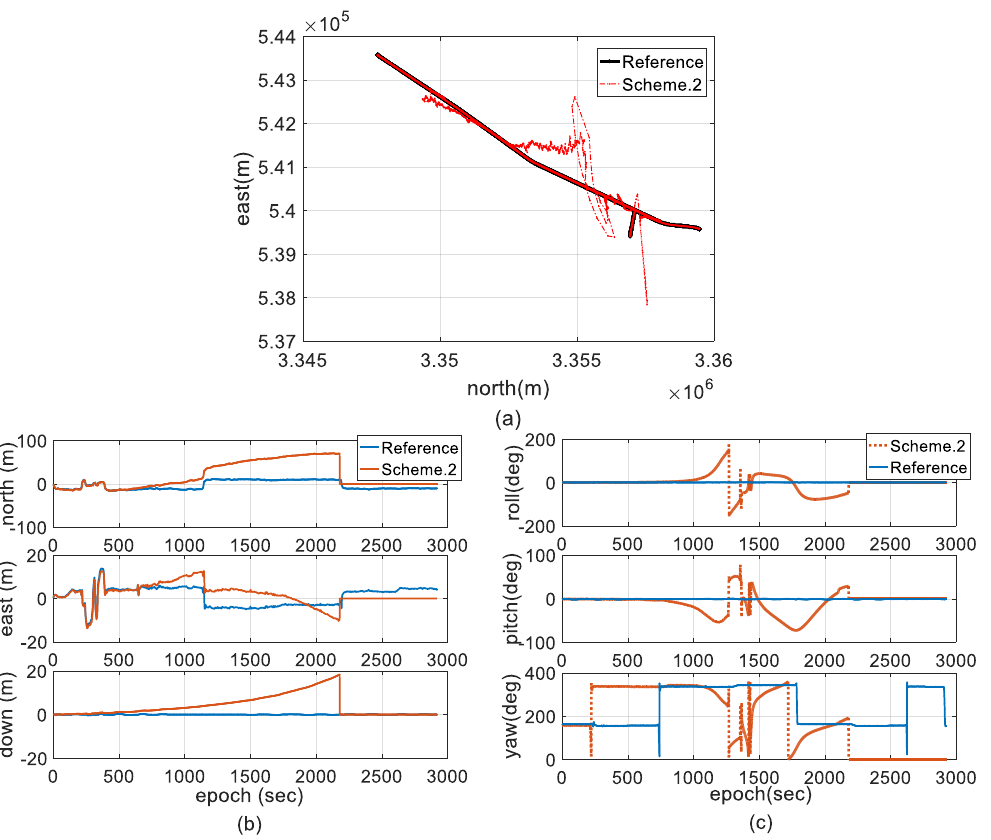
Figure 10. Comparisons of attitude and trajectory of Scheme 2 and the reference. ( a ) Attitude comparison; ( b ) velocity comparison; and ( c ) trajectory comparison.